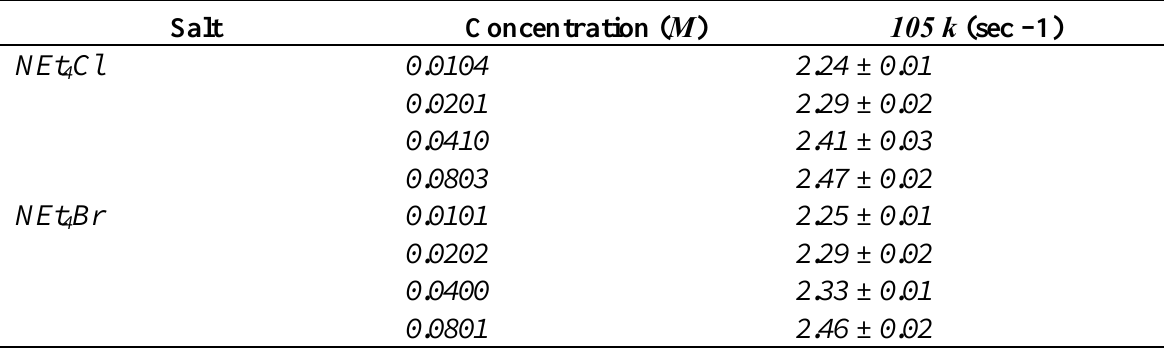
Table 3. Effect of added tetraethylammonium salts upon the specific rates of solvolysis of n -propyl chloroformate in ethanol at 25.0